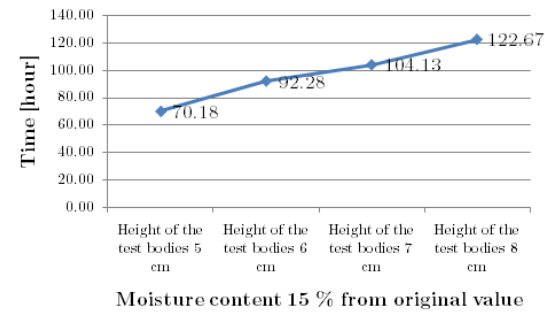
Figure 13. The decrease by 50 % from original value of the moisture content – linear dependence.